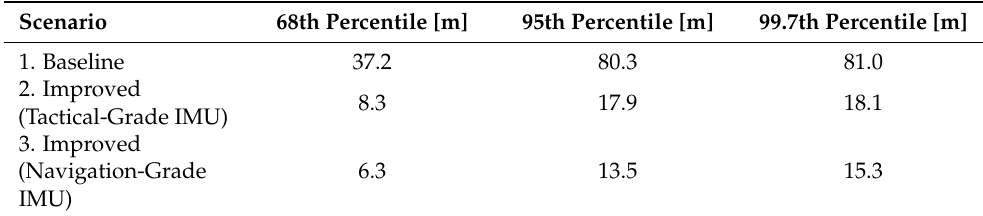
Table 13. Statistics highlighting the gain in performance when improving the EKF process noise (by changing the type of IMU). The percentiles refer to the time series of the horizontal uncertainty (3-sigma).